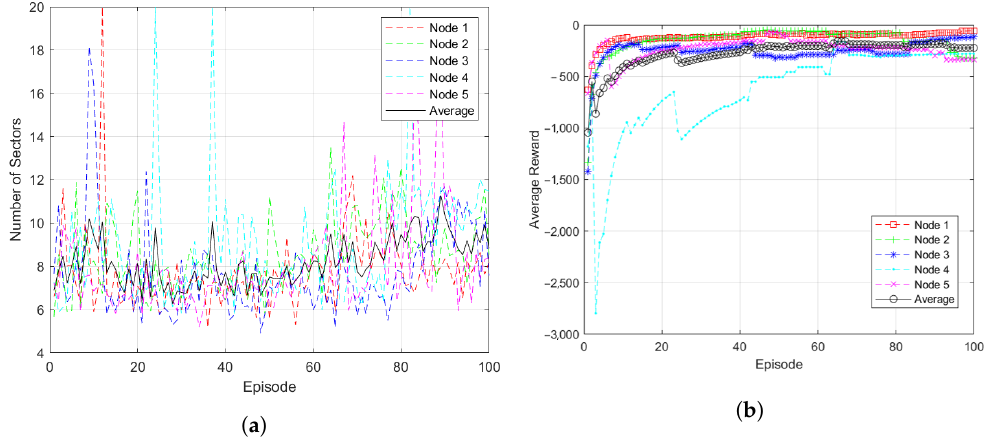
Figure 5. Simulation results of multiple nodes: ( a ) Subspace Change. ( b ) Episodic